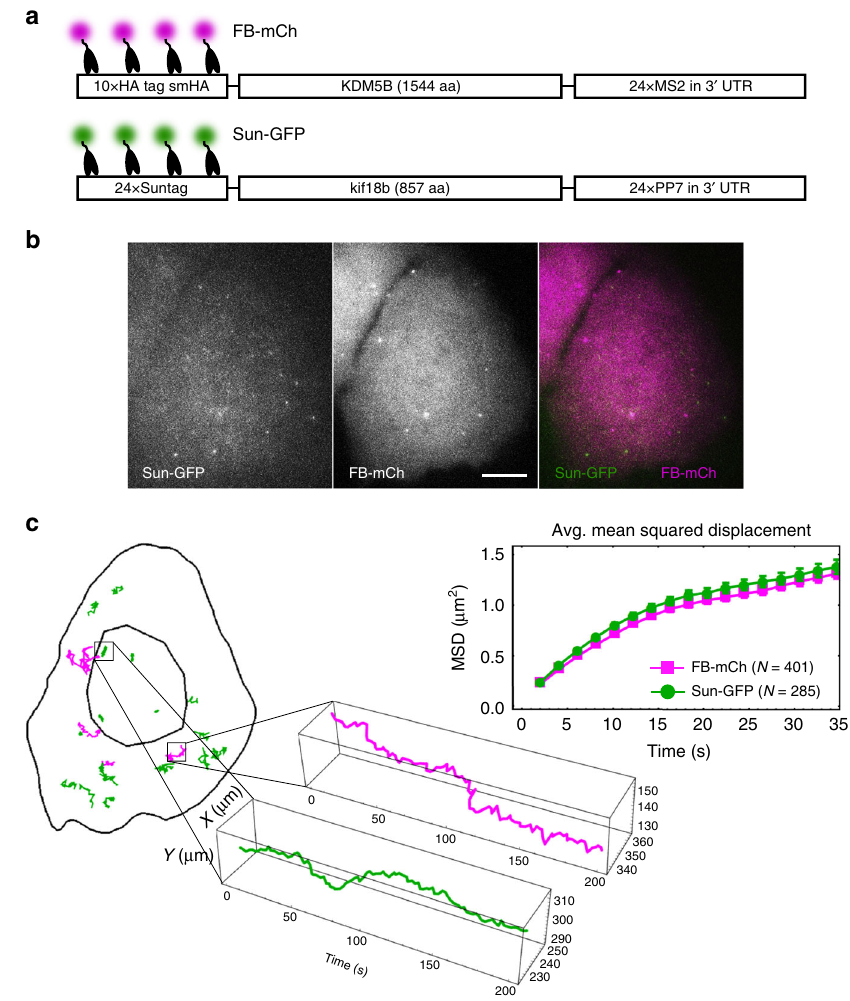
Fig. 7 Multiplexed imaging of single mRNA translation dynamics. a A diagram depicting frankenbody (FB-mCh) and Sun-GFP-labeling epitopes in the KDM5B and kif18b translation reporter constructs, respectively. b A representative living U2OS cell ( n = 8 cells from three independent experiments) showing nascent chain translation spots labeled by FB-mCh (magenta) or Sun-GFP (green). c The mask and tracks of the cell in b , and dynamics of a representative translation spot for each probe (Sun-GFP, green; FB-mCh, magenta). Right, the average mean squared displacement of FB-mCh (magenta) and Sun-GFP (green) translation sites (upper-right) from N = 401 tracks for FB-mCh, N = 285 tracks for Sun-GFP in eight cells in three independent experiments. Error bars, RNA-to-RNA SEM. Fits to the fi rst fi ve points of the MSD curves show the diffusion coef fi cients are: 0.016 ± 0.004 µ m 2 /s (95% CI) for FB-mCh and 0.019 ± 0.006 µ m 2 /s (95% CI) for Sun-GFP. Scale bars, 10 µ m. Source data are provided as a Source Data fi